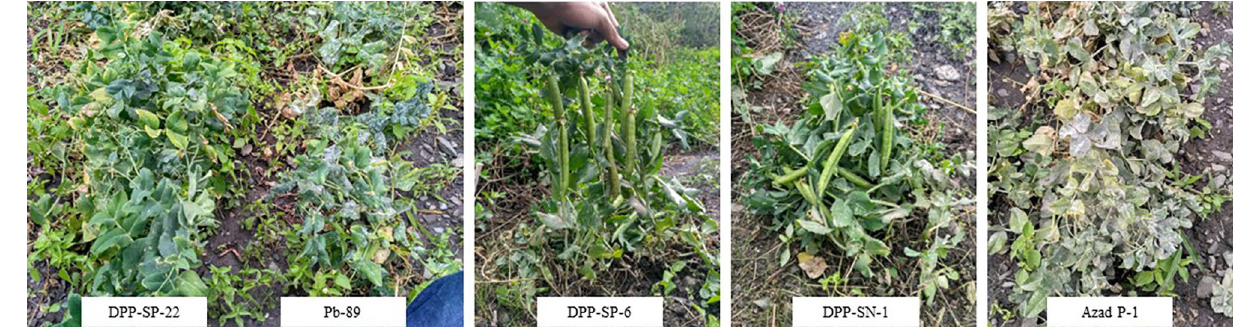
Figure 1. Comparative reaction of different genotypes to powdery mildew disease at